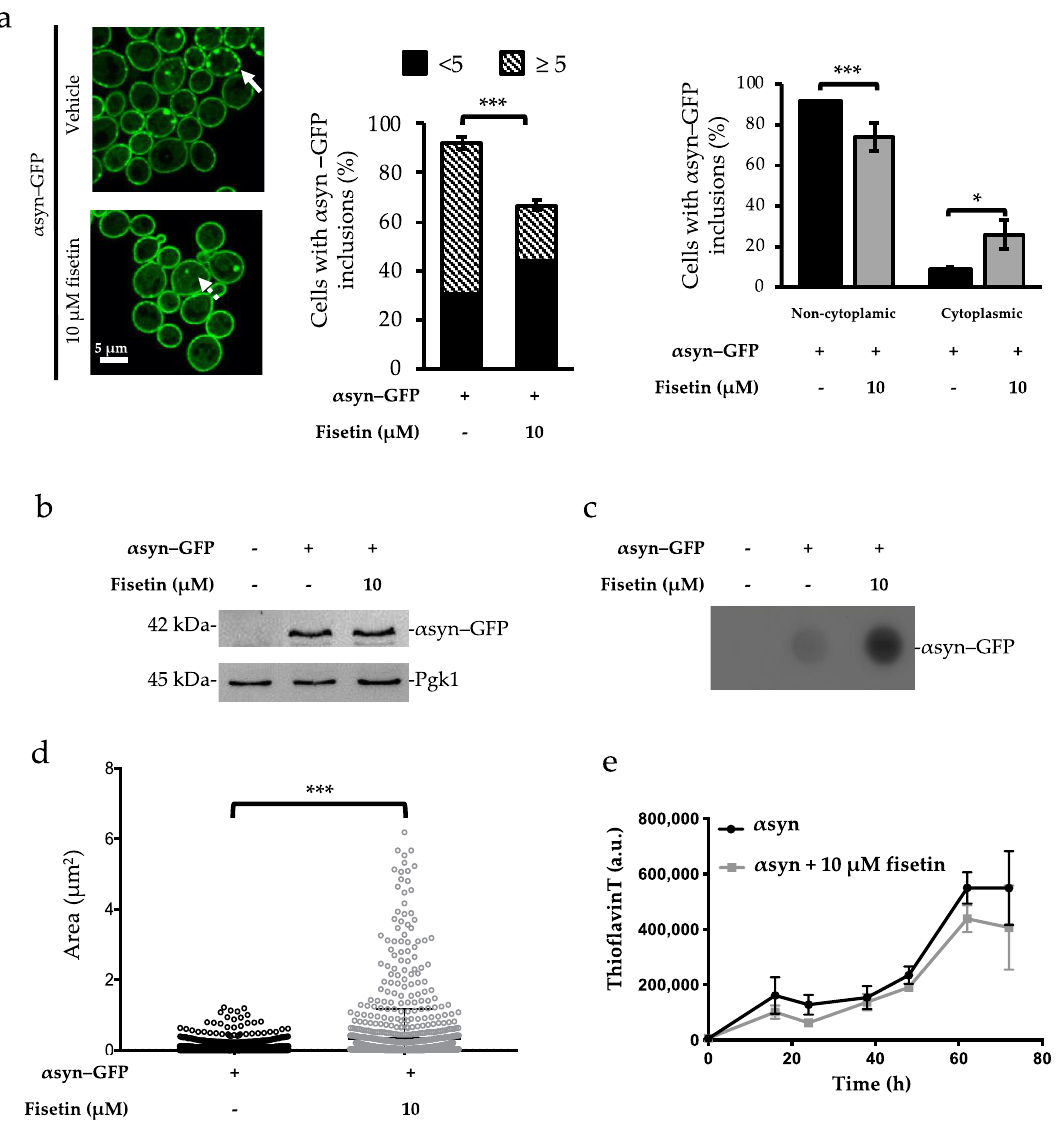
Figure 3. Fisetin reduces the percentage of cells with α syn–GFP inclusions and promotes the formation of α syn–GFP species with increased area. ( a ) Confocal microscopy imaging of α syn–GFP-expressing cells incubated in galactose medium ( α syn ON) supplemented or not with 10 µ M fisetin for 6 h at 30 ◦ C. Scale bar 5 µ m. Three biological replicates were performed, and a representative image is shown (left panel). Yeast cells containing α syn inclusions were counted and plotted (middle panel). Yeast cells containing inclusions only in the cytoplasm (dashed arrow) or displaying inclusions in the membranes (bold arrow) were counted and plotted (right panel). ( b ) α syn protein levels were assessed in α syn–GFP-expressing cells incubated in galactose medium ( α syn ON), supplemented or not with 10 µ M fisetin for 6 h at 30 ◦ C. Pgk1 was used as loading control. Three biological replicates were performed, and a representative image is shown. ( c ) Filter trap assay of yeast total protein extract. Trapped α syn–GFP species were detected using anti- α syn antibody. ( d ) Confocal images were used to measure the area of the inclusions using Icy Spot Detector. Detection was performed for a minimum of 1000 spots on GFP channel using a 1-, 7-, and 13-pixel scale with 100, 100, and 115 sensitivity, respectively. ( e ) Fibrilization processes of α Syn was monitored. A total of 70 µ M of α syn alone or in the presence of 10 µ M of fisetin was incubated at 37 ◦ under shaking. Samples were collected over time, and fibril formation was monitored by the increase in ThT fluorescence. Untreated α syn (black filled circle), α syn treated with 10 µ M of fisetin (gray filled square). The values represent the mean ± SEM of at least three biological replicates. Statistic differences are denoted by * p < 0.05, *** p < 0.001 vs. α syn–GFP